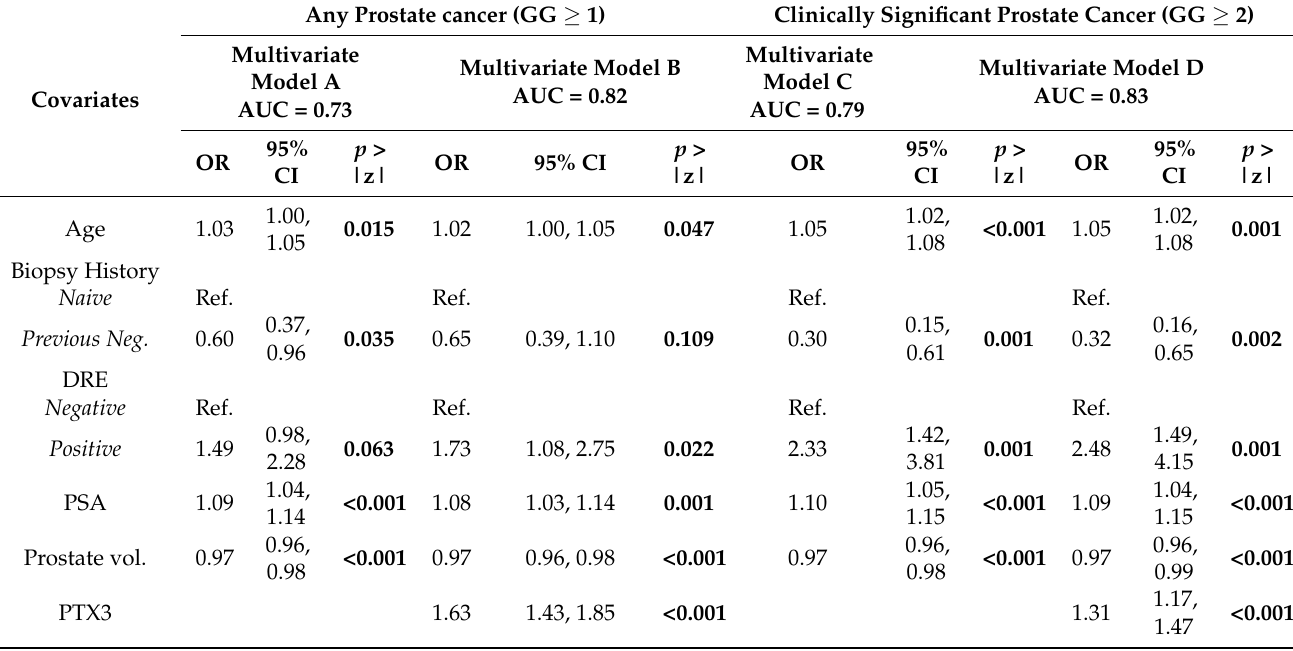
Table 3. Multivariate logistic regression predicting anyPCa and